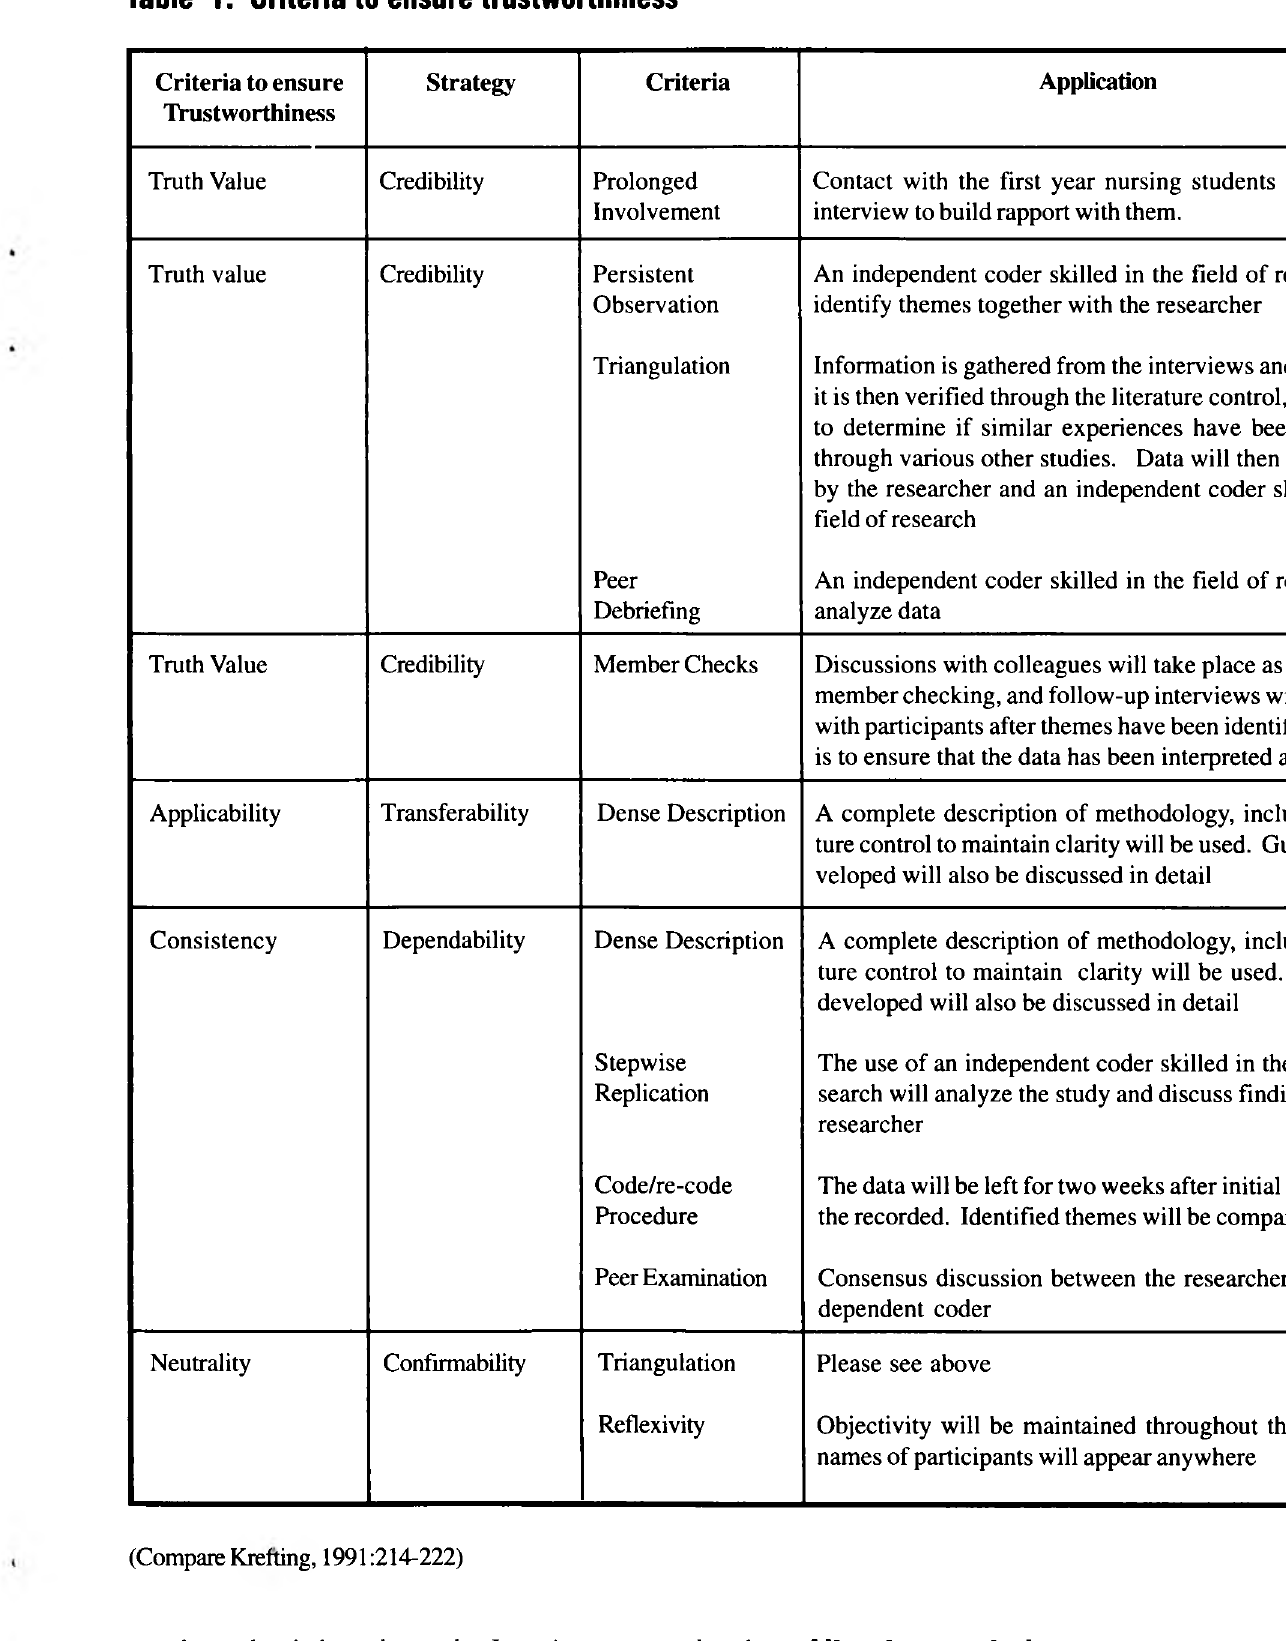
Table 1 : Criteria to ensure trustworthiness Criteria to